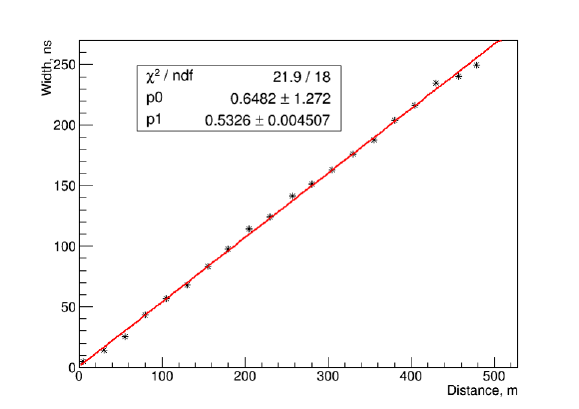
Figure 3. EAS disk width at di ff erent distances from axis at the observation level.